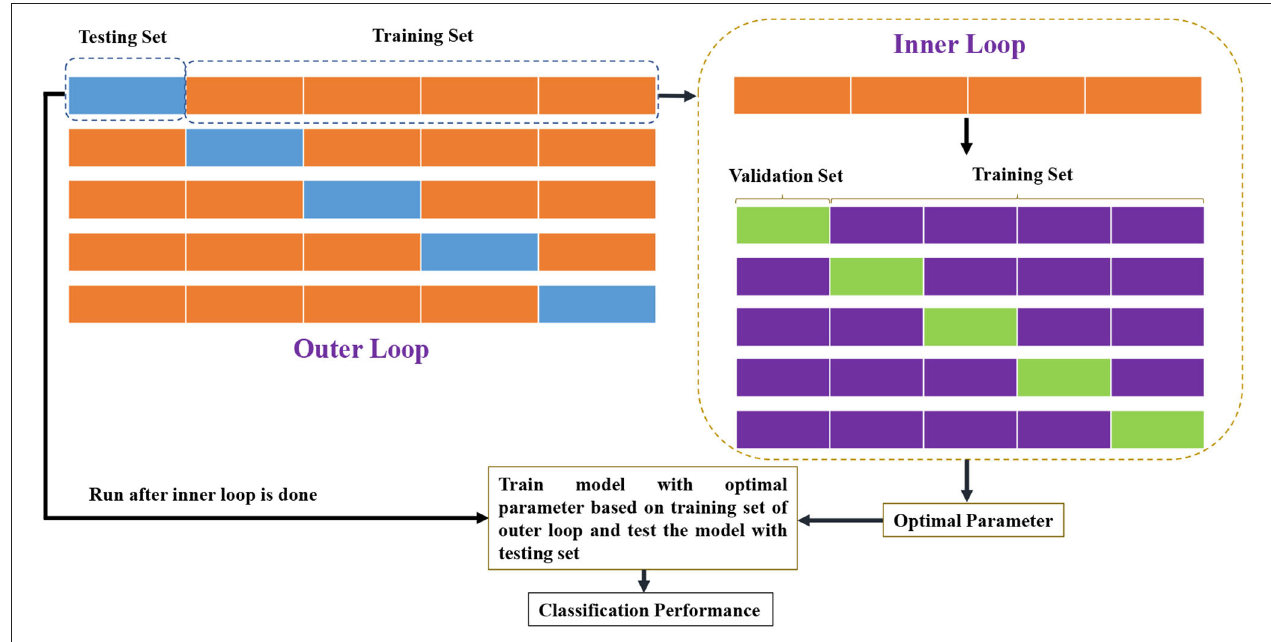
FIGURE 3 | The pipeline of 5-F CV in this study.